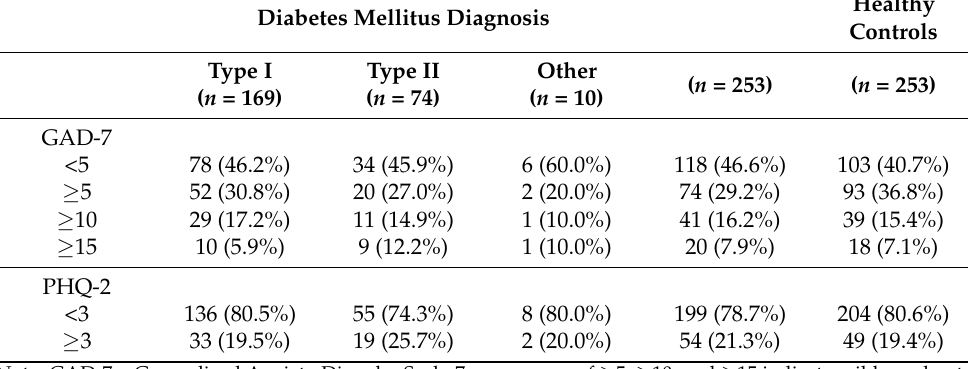
Table 3. Prevalence of generalized anxiety symptoms and depressive symptoms stratified by dia- betes